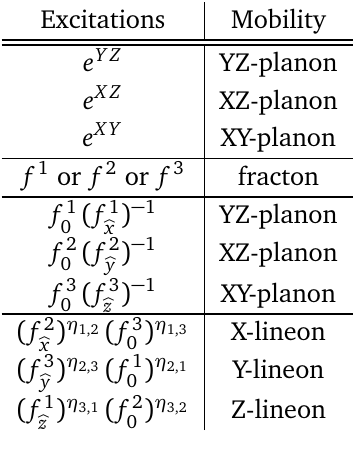
(cid:54)≡ 0 (mod N kl